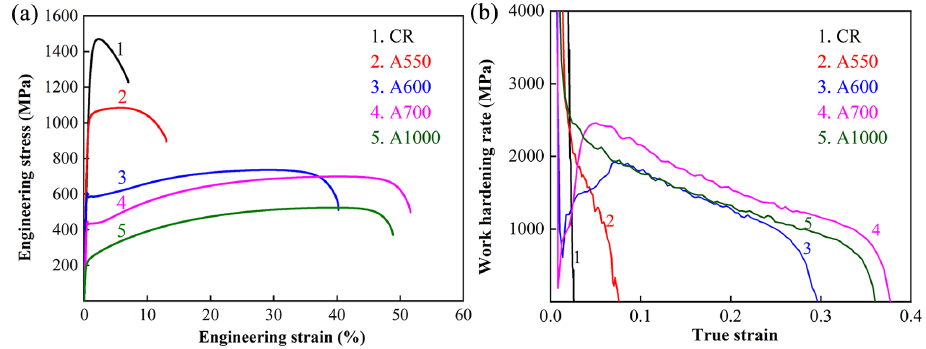
Figure 4. ( a ) Engineering stress–strain curves and ( b ) corresponding work-hardening rate of Fe- 30Mn-0.05C steels at RT.